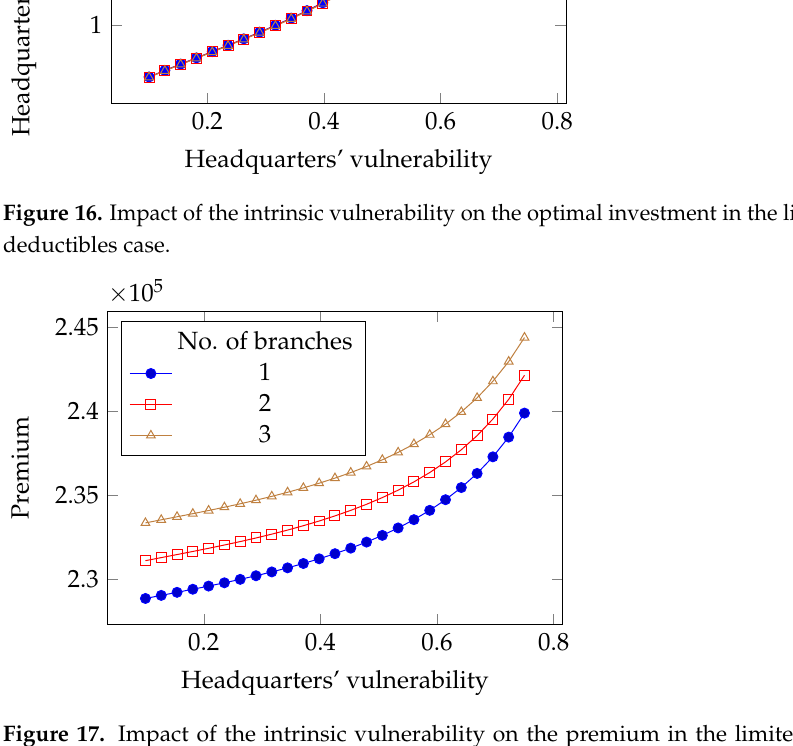
Figure 17. Impact of the intrinsic vulnerability on the premium in the limited liability with de- ductibles